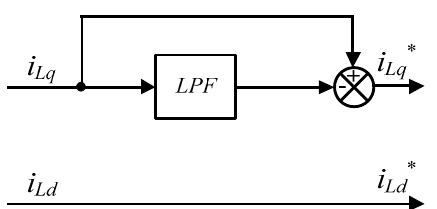
Figure 8. The direct-quadrature axis currents compensation signals of the APF.